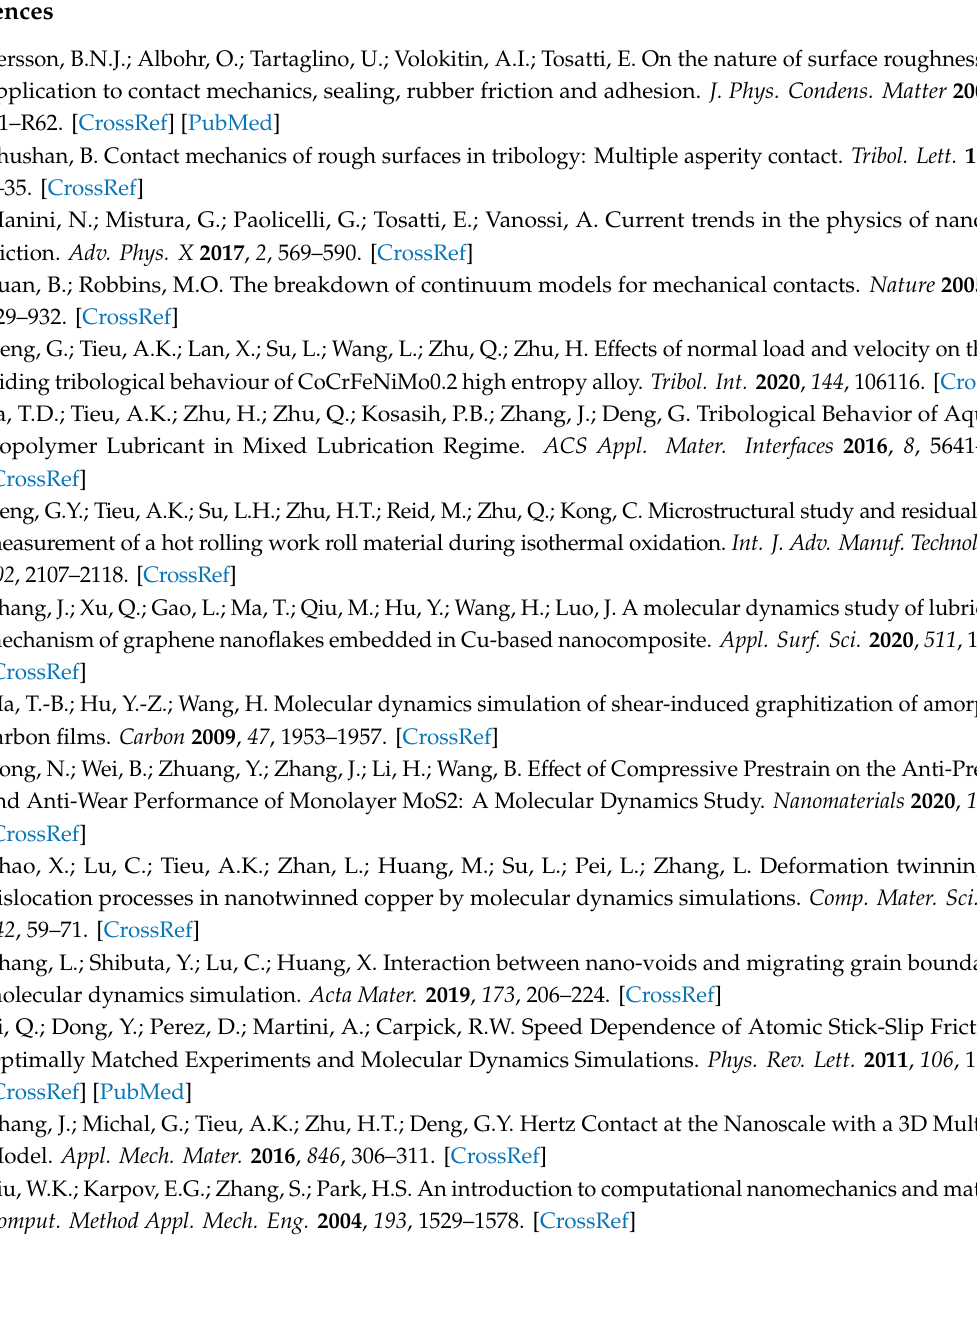
Figure S1: Geometry of the multiscale (a) and full MD (b) simulations, Figure S2: Comparisons between MU and full MD simulations: (a) Normalized contact area as a function of normalized indent displacement. (b) Kinetic energy near the substrate surface as a function normalized indent displacement. (c) Changes of stress component σ zz in a line along the z direction when normalized indent displacement is 1.31a. Indent displacement and Z are normalized by lattice constant of